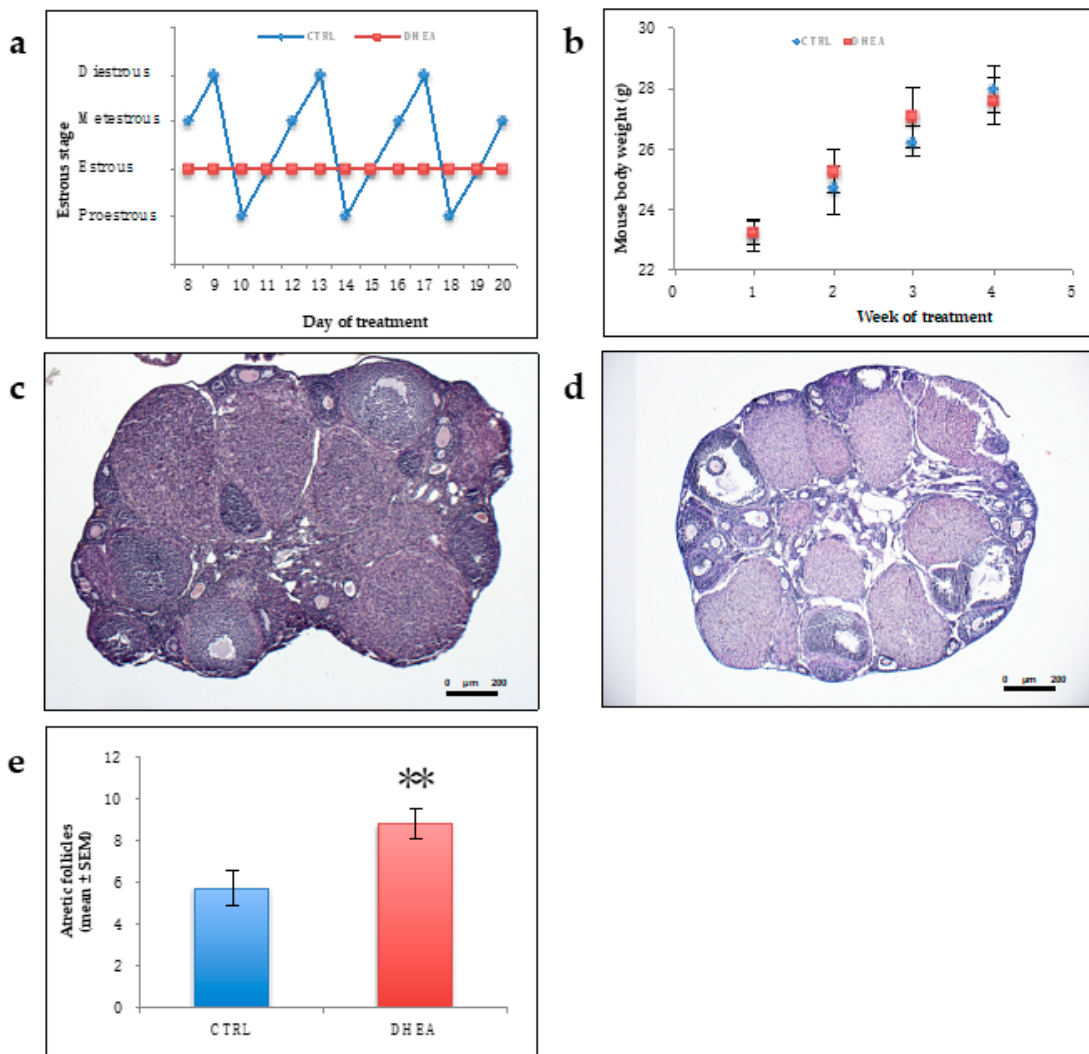
Figure 1. Estrous cycle, body weight, ovarian morphology in the mice. ( a ) Representative estrous cycle Figure 1 of one mouse from control and dehydroepiandrosterone (DHEA) group. ( b ) Body weight. Ten mice per experimental group were employed. ( c , d ) representative Haematoxylin and Eosin (H&E) staining of ovarian sections of CTRL ( c ) and DHEA ( d ) mice. ( e ) Atretic follicle. Three mice per experimental group were employed. Experiments were done in triplicate. **, p < 0.001, t